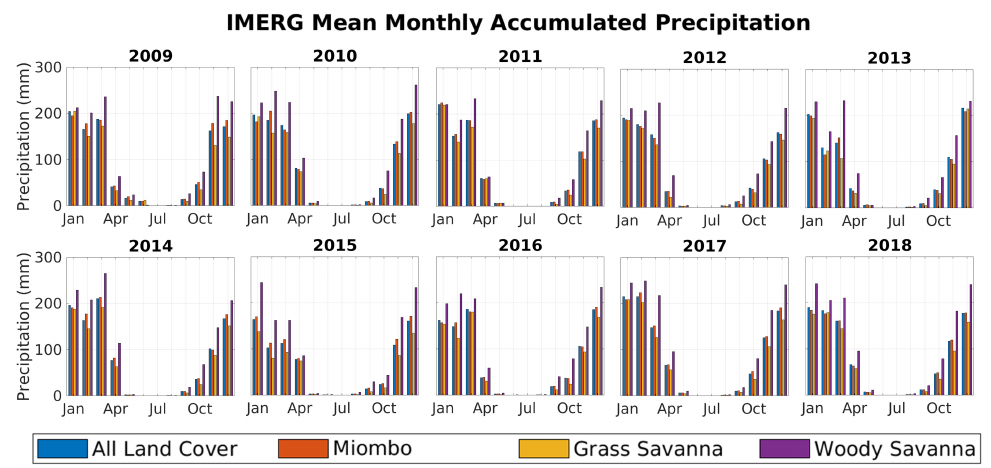
Figure 9. Bar graph comparisons of IMERG mean monthly accumulated precipitation for 2009–2018 for all land cover, miombo, grass savanna, and woody